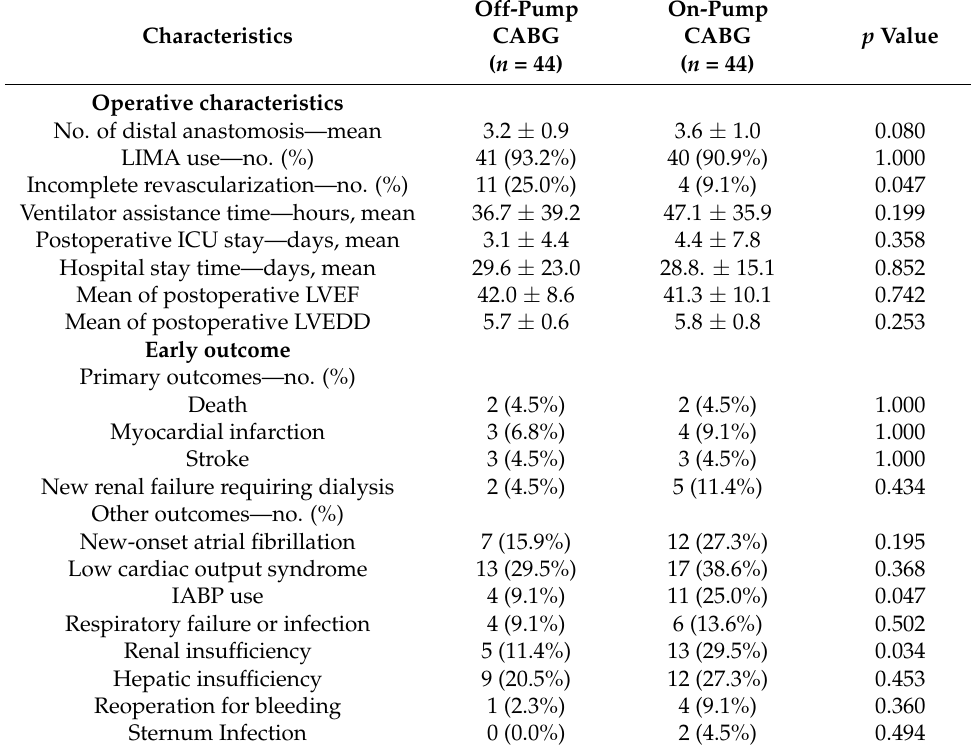
Table 4. Operative characteristics and early outcome of the patients after